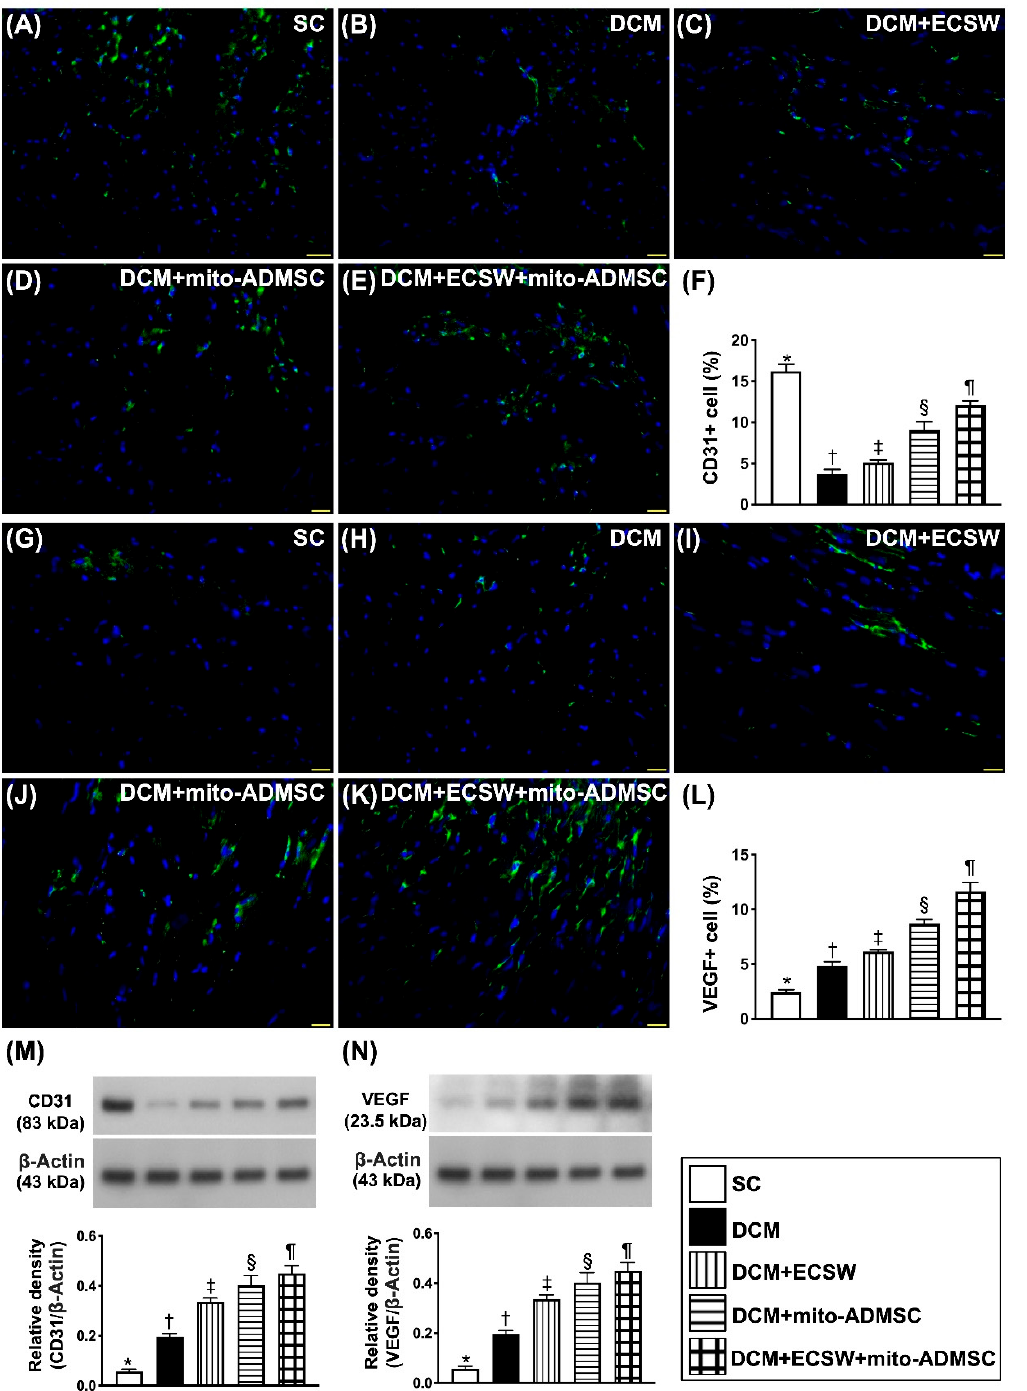
Figure 8. Angiogenesis in LV myocardium 7 weeks after DCM induction. ( A – E ) Illustrating the immunofluorescent (IF) microscopic finding (400 × ) for identification of cellular expression of CD31 (green color). ( F ) Analytical result of number of CD31+ cells, * vs. other groups with di ff erent symbols (†, ‡, §, ¶), p < 0.0001. ( G – K ) Illustrating the IF microscopic finding (400×) for identification of cellular expression of vascular endothelial growth factor (VEGF) (green color). ( L ) Analytical result of number of VEGF+ cells, * vs. other groups with di ff erent symbols (†, ‡, §, ¶), p < 0.0001. Scale bar in right lower corner represents 50 μ m. ( M ) Protein expression of CD31, * vs. other groups with di ff erent symbols (†, ‡, §, ¶), p < 0.0001. ( N ) Protein expression of VEGF, * vs. other groups with di ff erent symbols (†, ‡, §, ¶), p < 0.0001. All statistical analyses were performed by one-way ANOVA, followed by Bonferroni multiple comparison post hoc test ( n = 6 for each group). Symbols (*, †, ‡, ¶) indicate significance (at 0.05 level). SC = sham control; DCM = dilated cardiomyopathy; ECSW = extra- corporeal shock wave; mito = mitochondria.